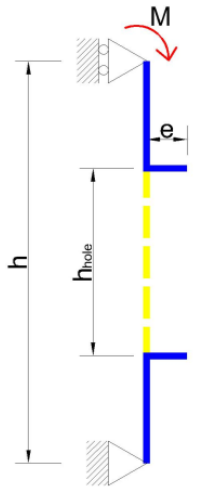
Figure 4. Web model used to determine 𝑘 𝜑 .